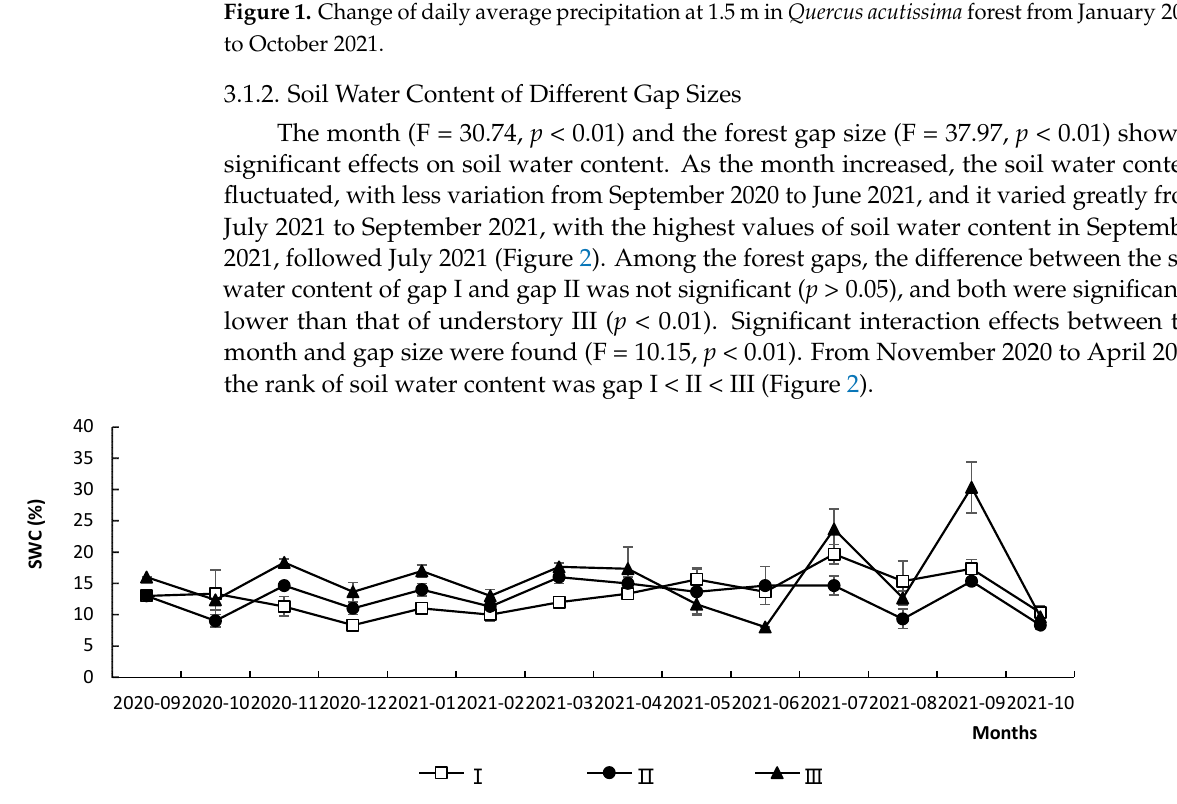
Figure 2. Monthly dynamic changes of soil water content under different gap sizes in Quercus acutis- sima forest from September 2020 to October 2021.